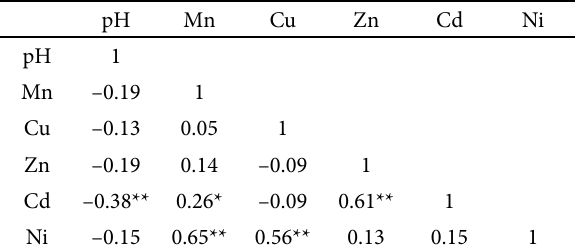
Table 4. Correlation between metals analyzed in leachate samples ( n = 81)